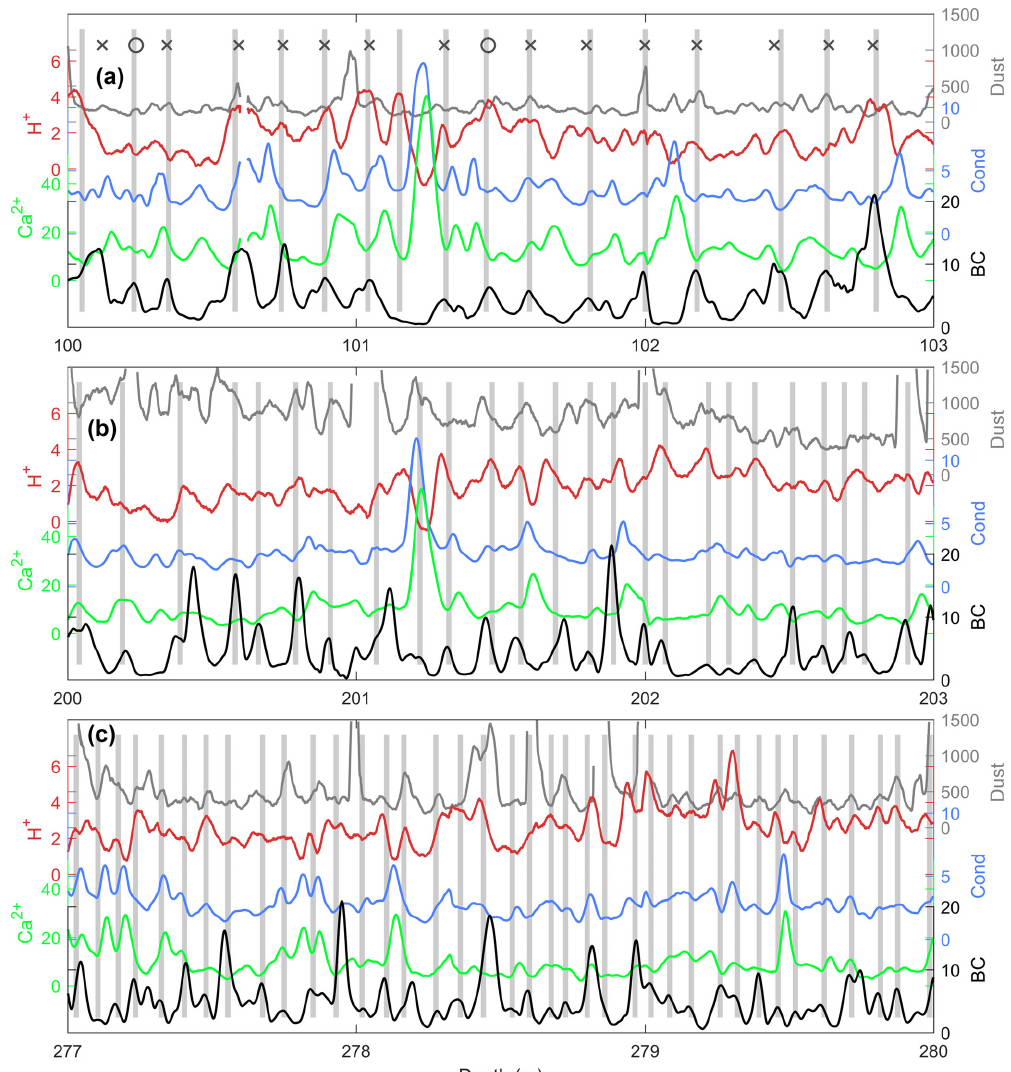
Figure 6. CFA data and StratiCounter annual-layer counts (grey bars) in three 3m long sections (a–c) of the RICE core. In general, the most distinct annual signal is found in the BC record, but the other records also contain valuable information on the annual layering. Due to contamination from drill fluid, the dust record was not used for layer counting below 129m. For the top section (a) , the preliminary set of manual layer counts used for initializing StratiCounter are shown: crosses (x) indicate certain layers and circles (o) indicate uncertain layers. For this section, the manual layer counts have a bias towards counting too few layers in total. This is a general tendency of the manual timescale, resulting in a manually counted age for the Pleiades tephra that is a few decades younger than observed in WAIS